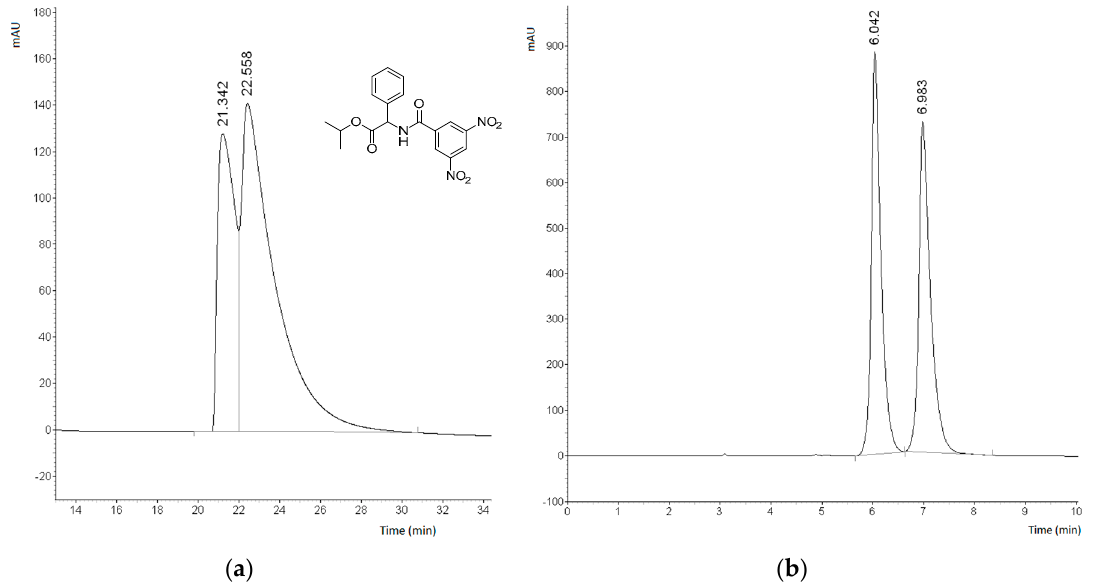
Figure 5. Chromatogram of the separation of racemate 19 on CSP-10 ( a ) and CSP-8 ( b ); mobile phase hexane-2-propanol = 80:20, flow 1mL/min, UV detection at 254 nm.